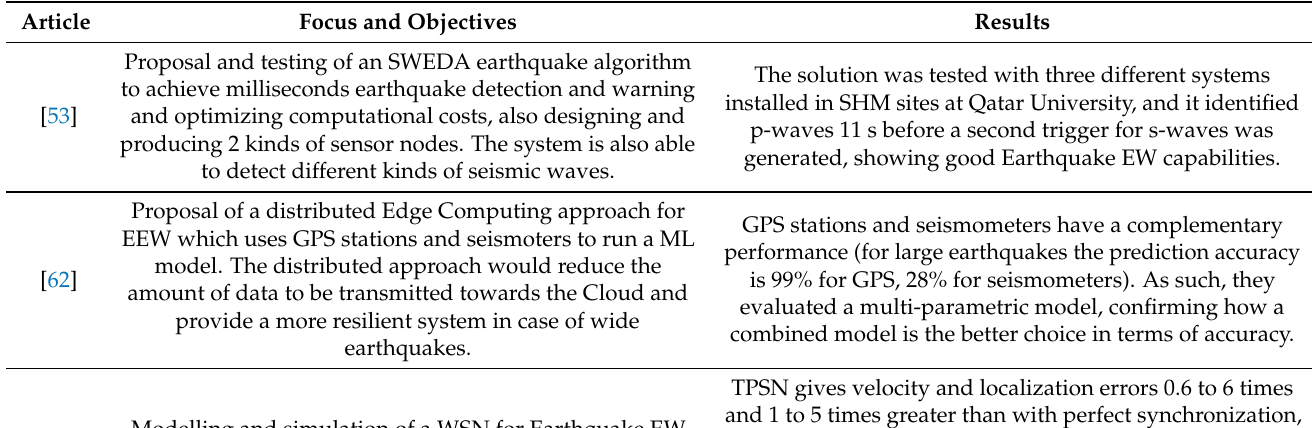
Table 3. Reviewed Articles in Earthquake